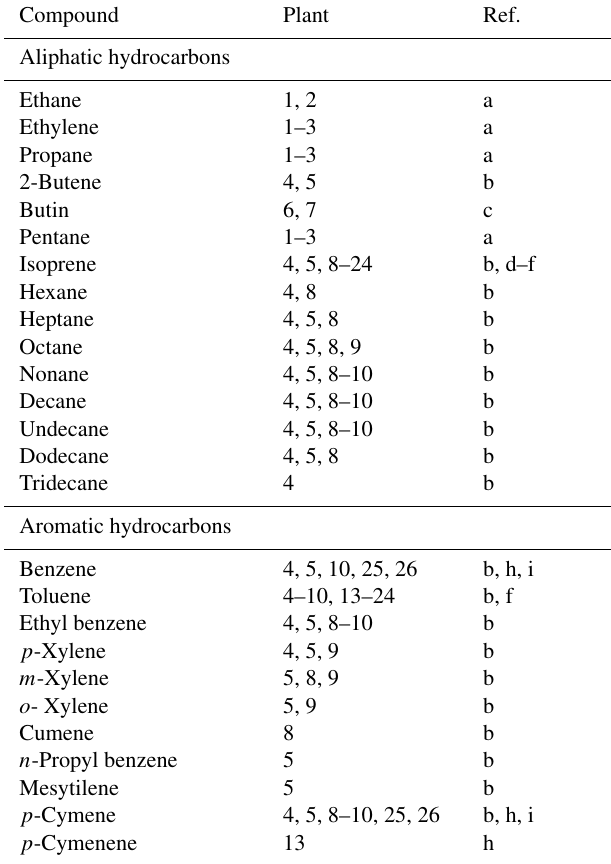
Table 2. Organic compounds in volatile emissions of leaf